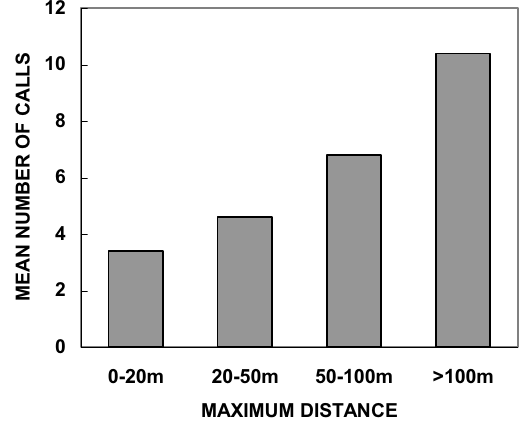
Fig. 2 – Mean number of calls in exchanges occuring at different classesofmaximumdistanceofparticipantsrelativelytothefocal